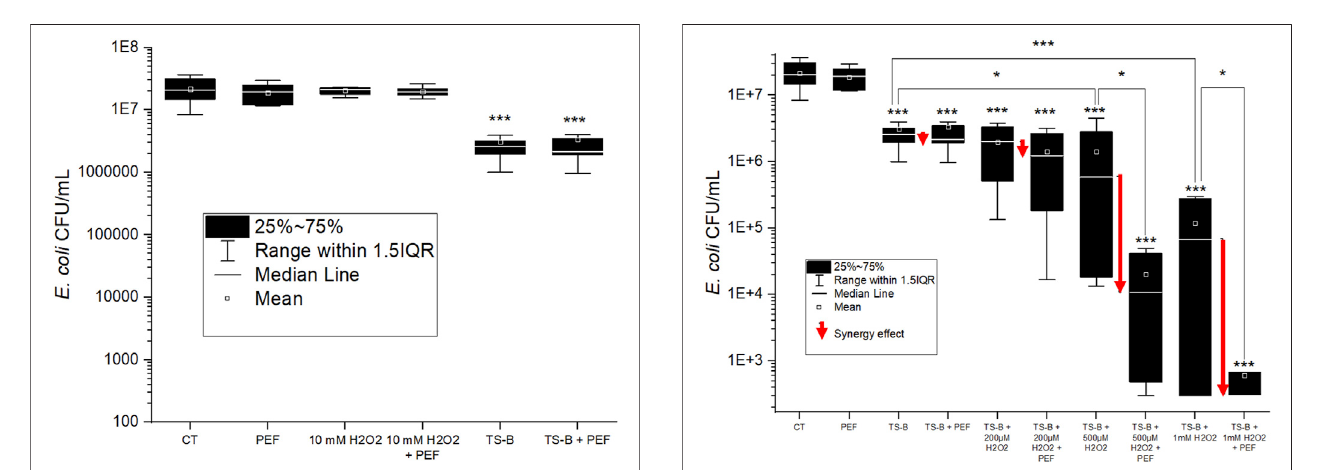
FIGURE 6 | E. coli population (CFU/ml) for PEF treatment only, 10 min incubation in 10 mM H 2 O 2 only, and with PEF treatment, PAW generated by TS-B closed air reactor, 10 min incubation in PAW only and coupled with PEF treatment. One-way ANOVA test, (*) p -value < 0.05; (**) p -value < 0.01; and (***) p -value < 0.001 with respect to control (CT). Boxes and whiskers show the median, mean value, interquartile range (IQR), and error bars corresponding to